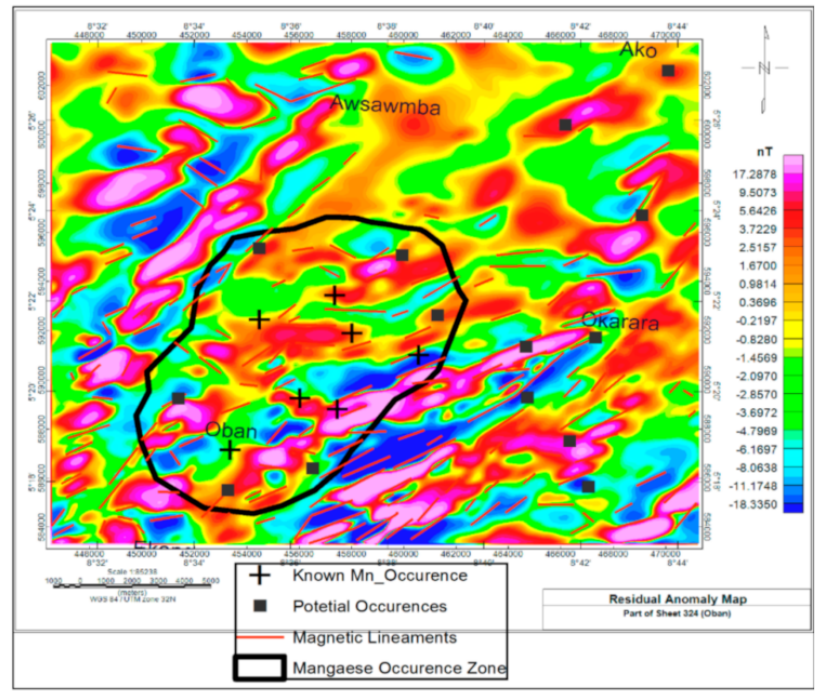
Figure 14. Residual magnetic anomaly